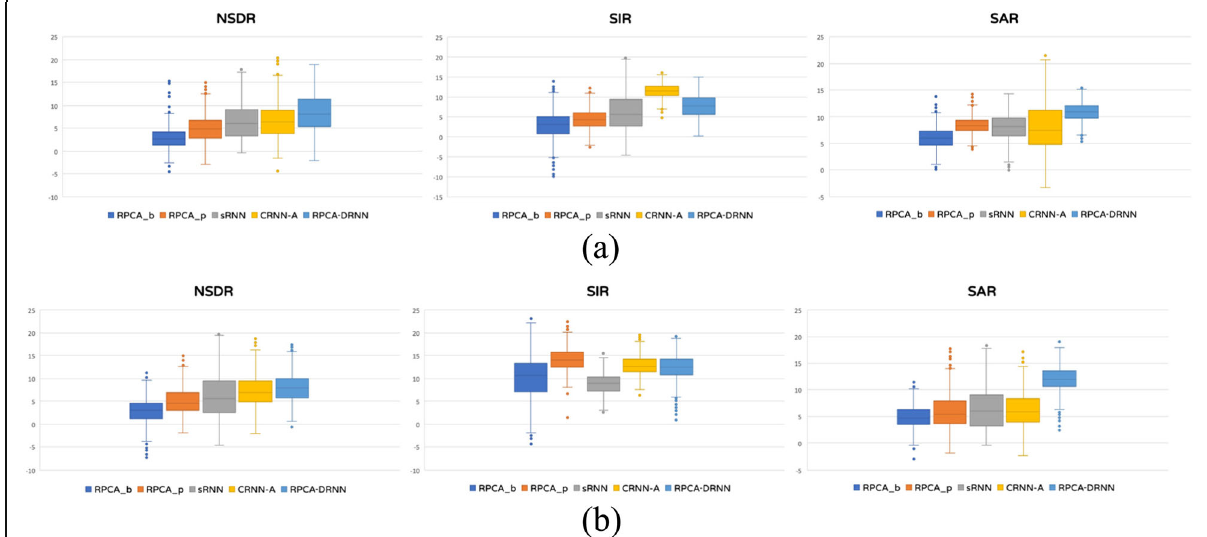
Fig. 6 Box plots of the NSDR, SIR, and SAR of the separated a vocal and b accompaniment of RPCA-DRNN and RPCA_b, RPCA_p, sRNN, and CRNN-A on MIR-1K